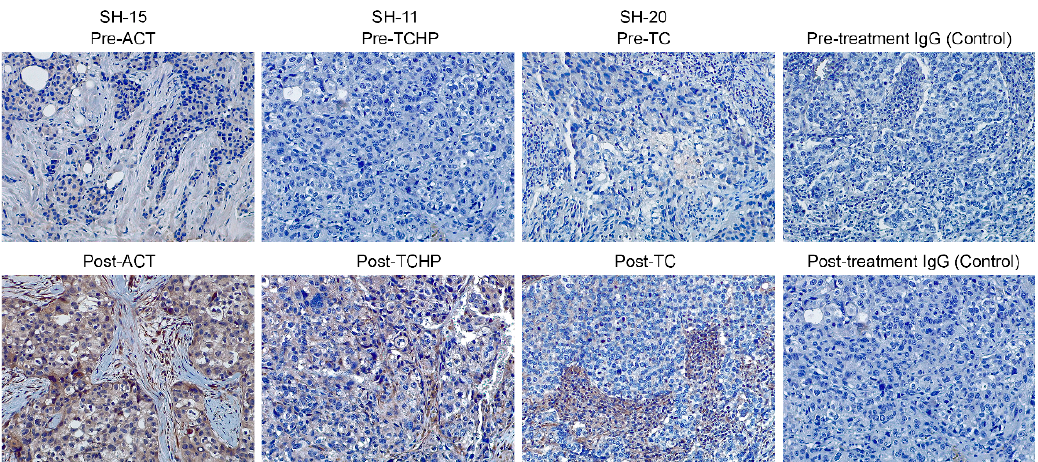
Figure 4. The presence of the ABCA1 protein (brown color) in breast cancer patient tumor sections, pre ‐ and post ‐ current ‐ standard ‐ of ‐ care ‐ treatments (ACT, TCHP, and TC) was examined by immunohistochemical staining with IgG used as a control for non ‐ specific staining (20× original